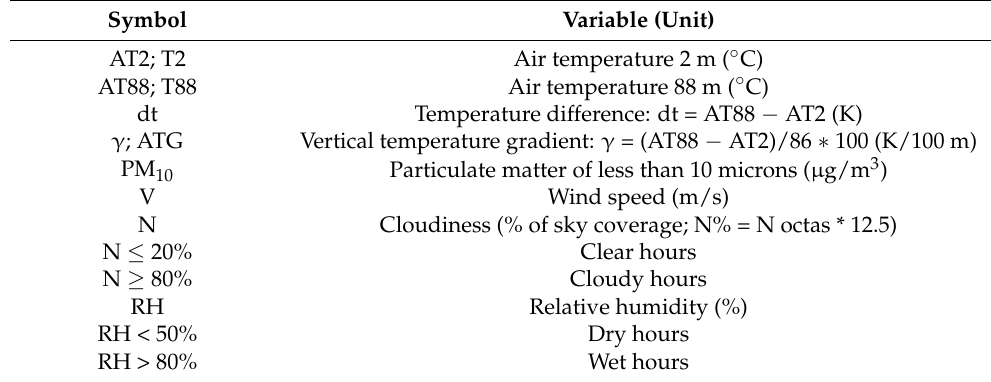
Table 1. List of meteorological variables (hourly values).